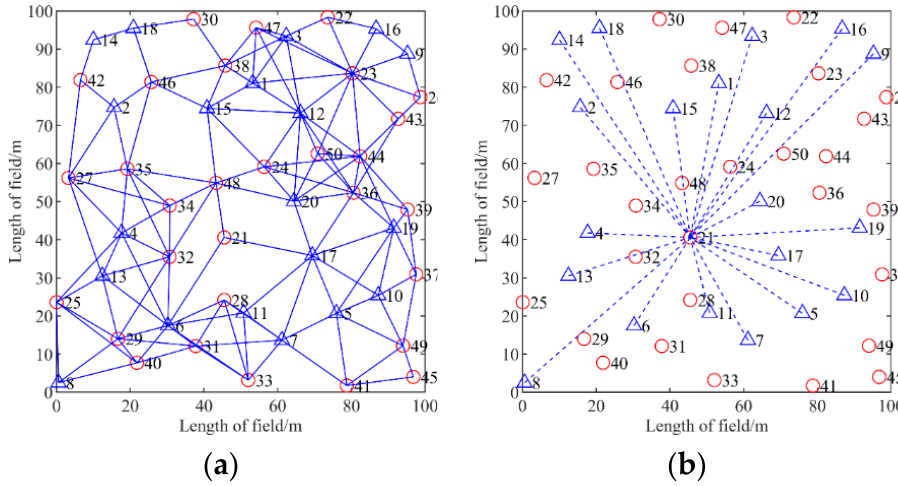
Figure 4. Heterogeneous wireless sensor network model: ( a ) network connections; ( b ) distance from all anchor nodes to unknown node 21.